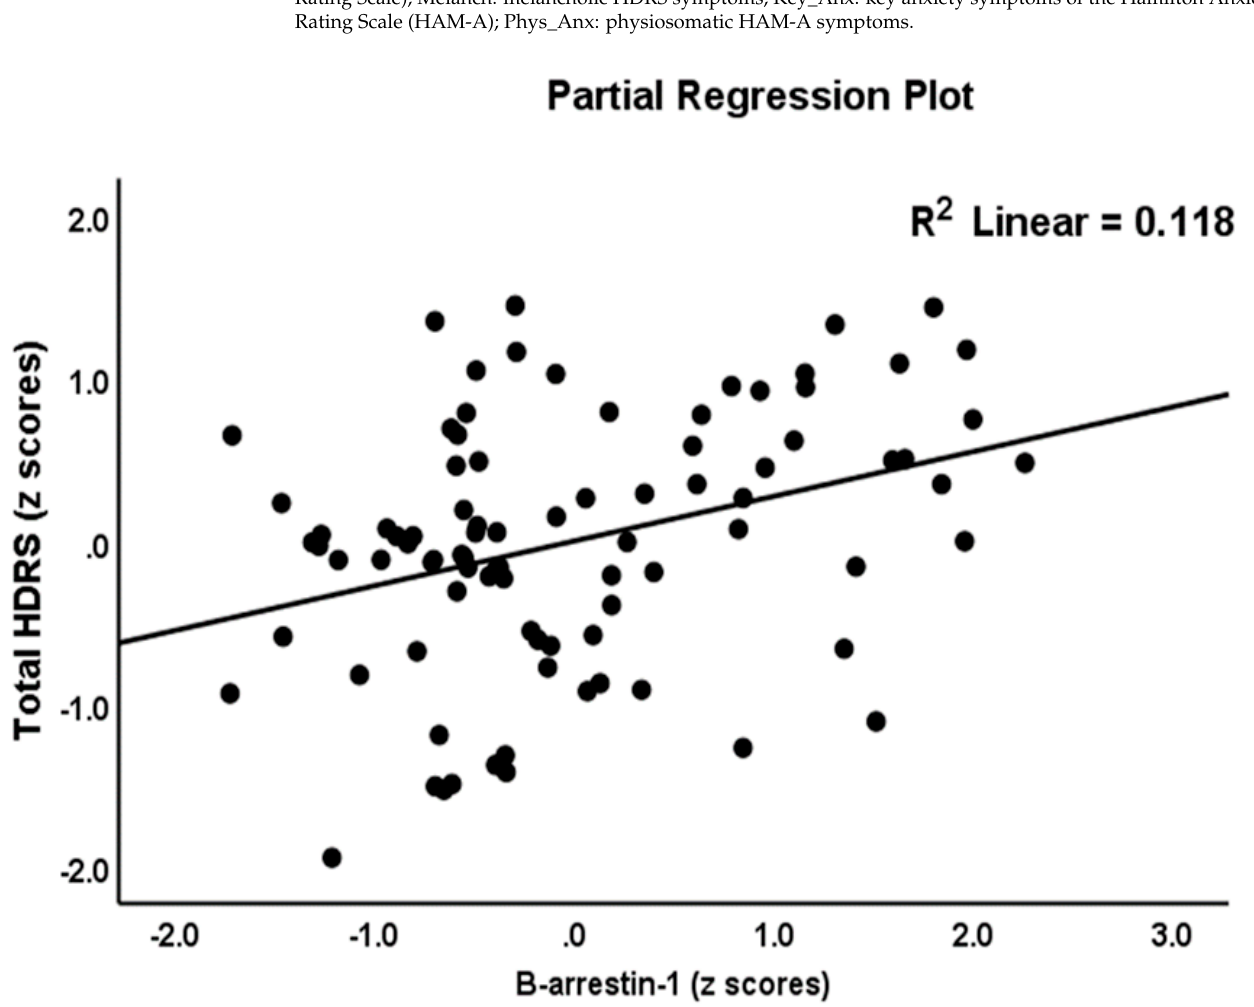
Figure 1. Partial regression plot with the total 17-item Hamilton Depression Rating Scale (HDRS) score as the dependent variable and β -arrestin-1 as explanatory variable.